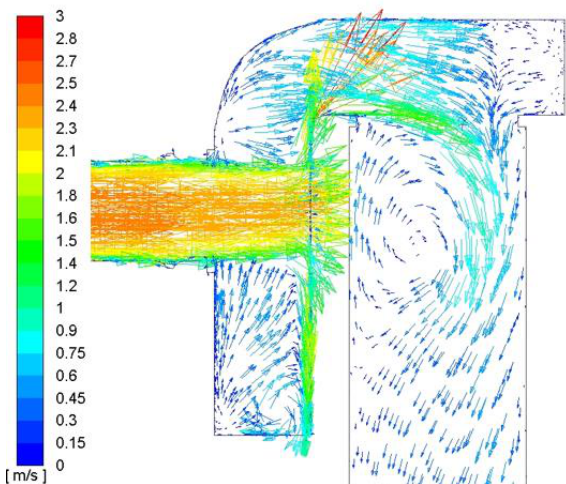
Fig. 9. Velocity Vectors Colored by Velocity Magnitude v / m/s: unmodified geometry